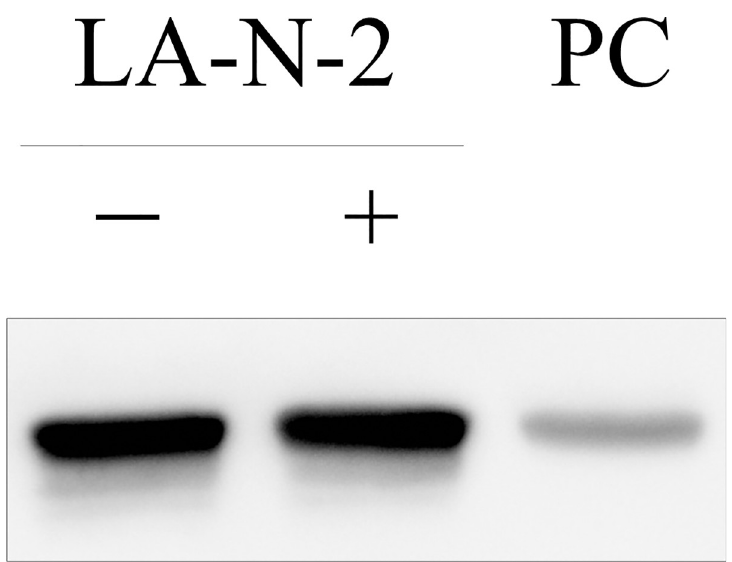
Fig 2. The expression of muscarinic acetylcholine receptor M2 on LA-N-2 cells. LA-N-2 cells were lysed before (-) or after (+) the treatment with the assay medium for 5 h and subjected to SDS-PAGE along with mouse brain tissue lysate as a positive control (PC). Lysates/proteins at 10 μ g per lane.